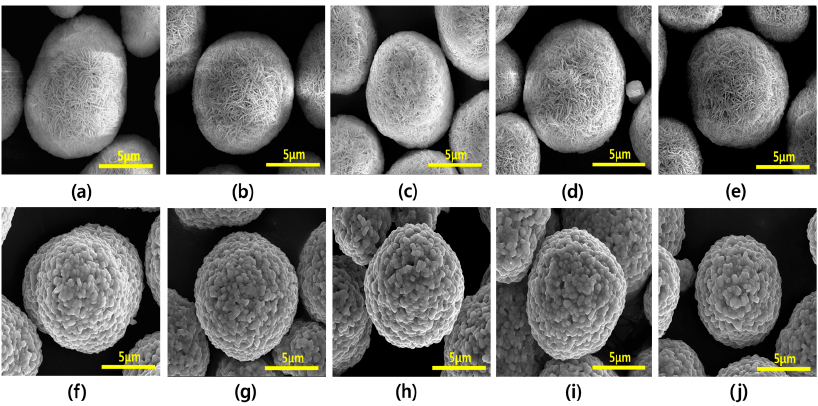
Figure 1. SEM images of the Sn-incorporated precursors (( a ) pristine, ( b ) Sn 0.5 wt %, ( c ) Sn 1.0 wt %, ( d ) Sn 1.5 wt %, and ( e ) Sn 3.0 wt %) and the cathode active materials (( f ) pristine, ( g ) Sn 0.5 wt %, ( h ) Sn 1.0 wt %, ( i ) Sn 1.5 wt %, and ( j ) Sn 3.0 wt %).